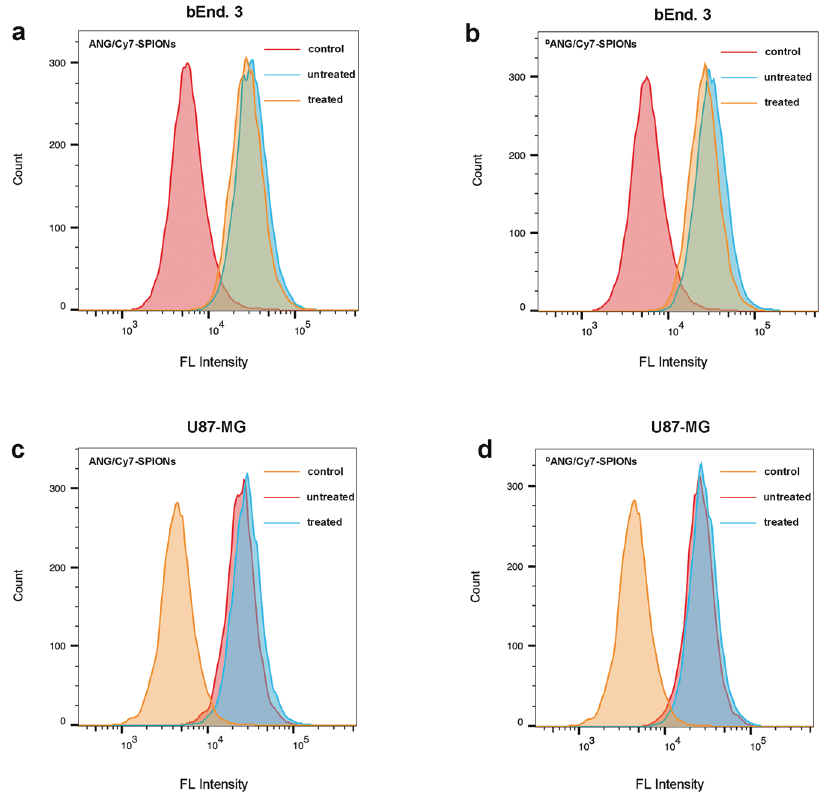
Fig. 6 a FCM pro fi les displaying cellular uptake of the ANG/Cy7-PEG-SPIONs probes before and after incubation with human serum after culturing for 4 h with bEnd.3 cells; b FCM pro fi les displaying cellular uptake of the D ANG/Cy7-PEG-SPIONs probes before and after incubation with human serum after culturing for 4 h with bEnd.3 cells; c FCM pro fi les displaying cellular uptake of the ANG/Cy7-PEG-SPIONs probes before and after incubation with human serum after culturing for 4 h with U87-MG cells; d FCM pro fi les displaying cellular uptake of the D ANG/Cy7-PEG-SPIONs probes before and after incubation with human serum after culturing for 4 h with U87-MG cells. Data from at least three independent experiments are shown as the means ± SEMs, n =